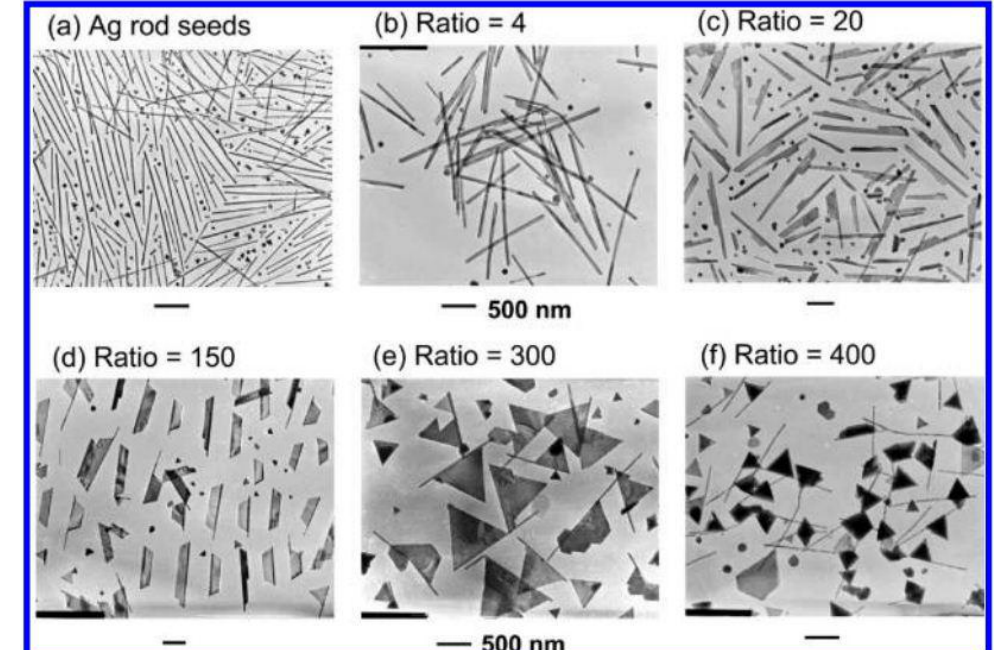
] /[AgNO ] ratios (reprinted with permission from [43]. Copyright 3 2 3 1